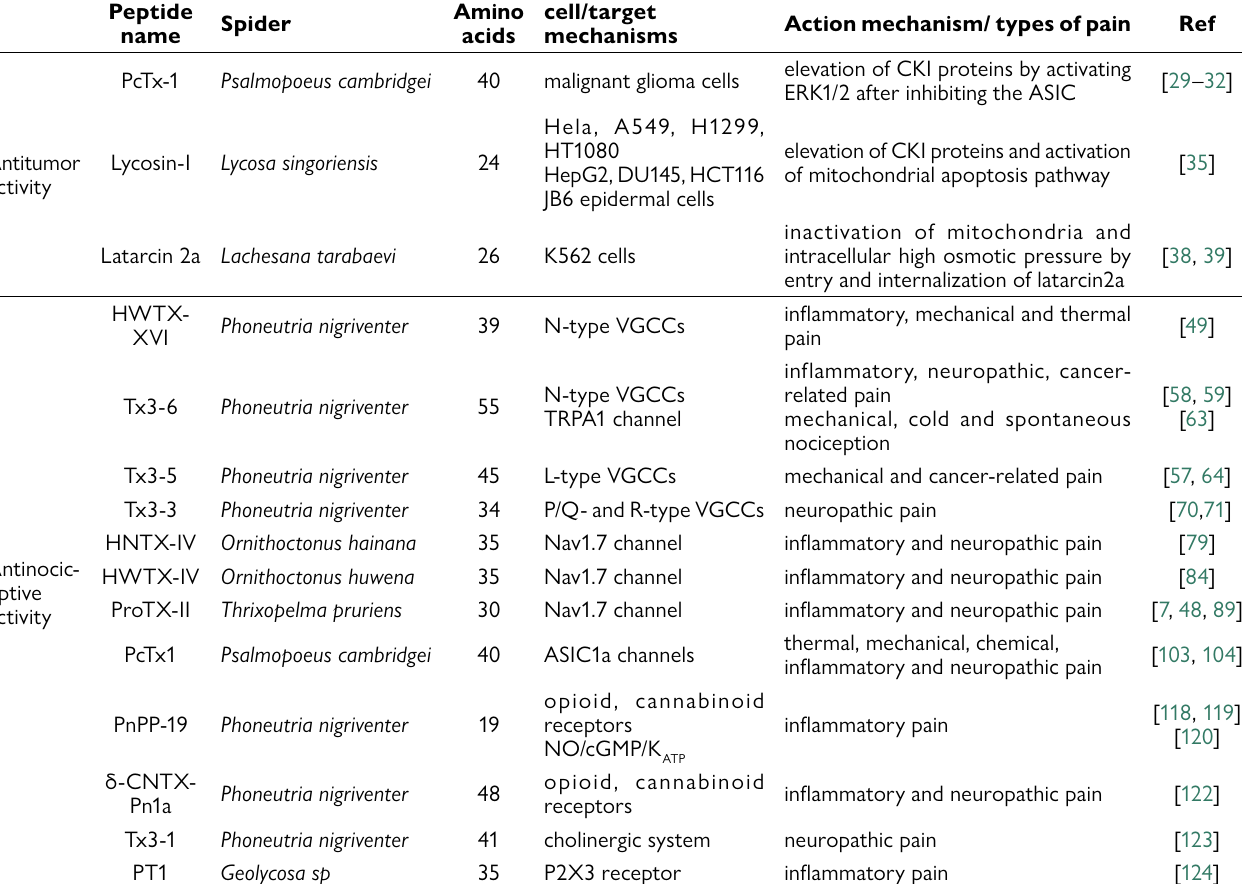
Table 1. Some examples of spider venom peptides as potential drug candidates with their anticancer and antinociceptive